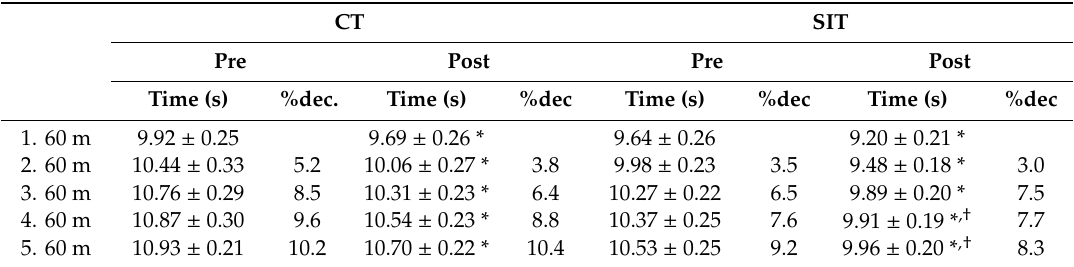
Table 2. Performance on the repeated sprint test before and after eight weeks of continuous training (CT) and sprint interval training (SIT). CT SIT Pre Post Pre Post Time (s) %dec. Time (s) %dec Time (s) %dec Time